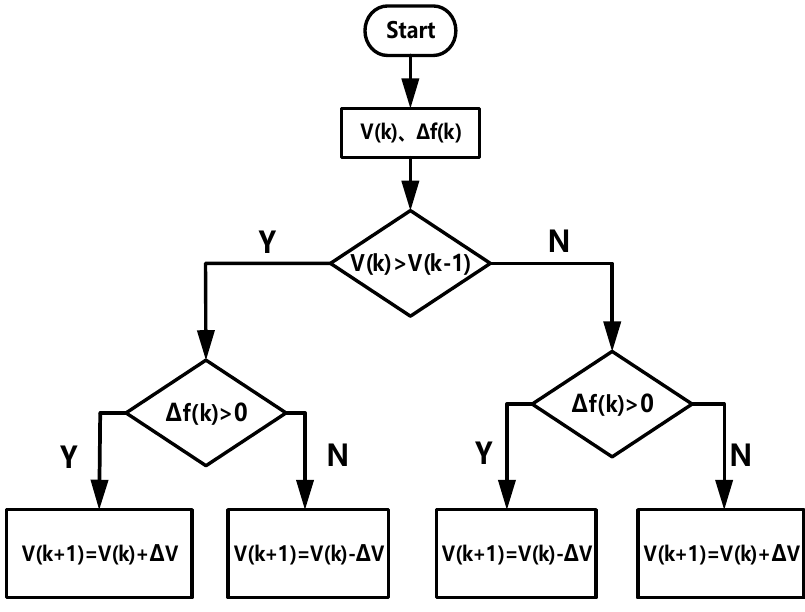
Figure 4. Logical block diagram of P&O MPPT.